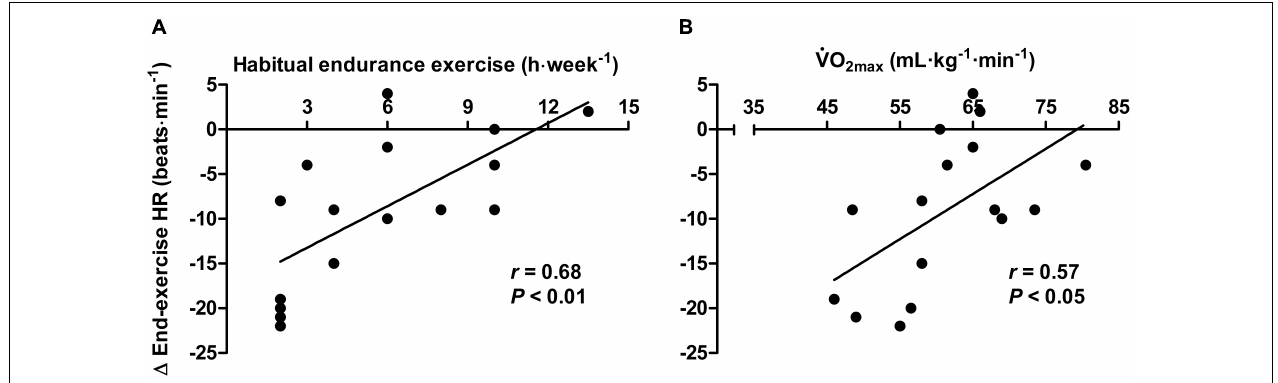
FIGURE 2 | Relationship between habitual endurance exercise volume (A) and aerobic fitness (B) and the change in heart rate response to exercise-heat-stress after 6-day post-exercise hot water immersion heat acclimation.